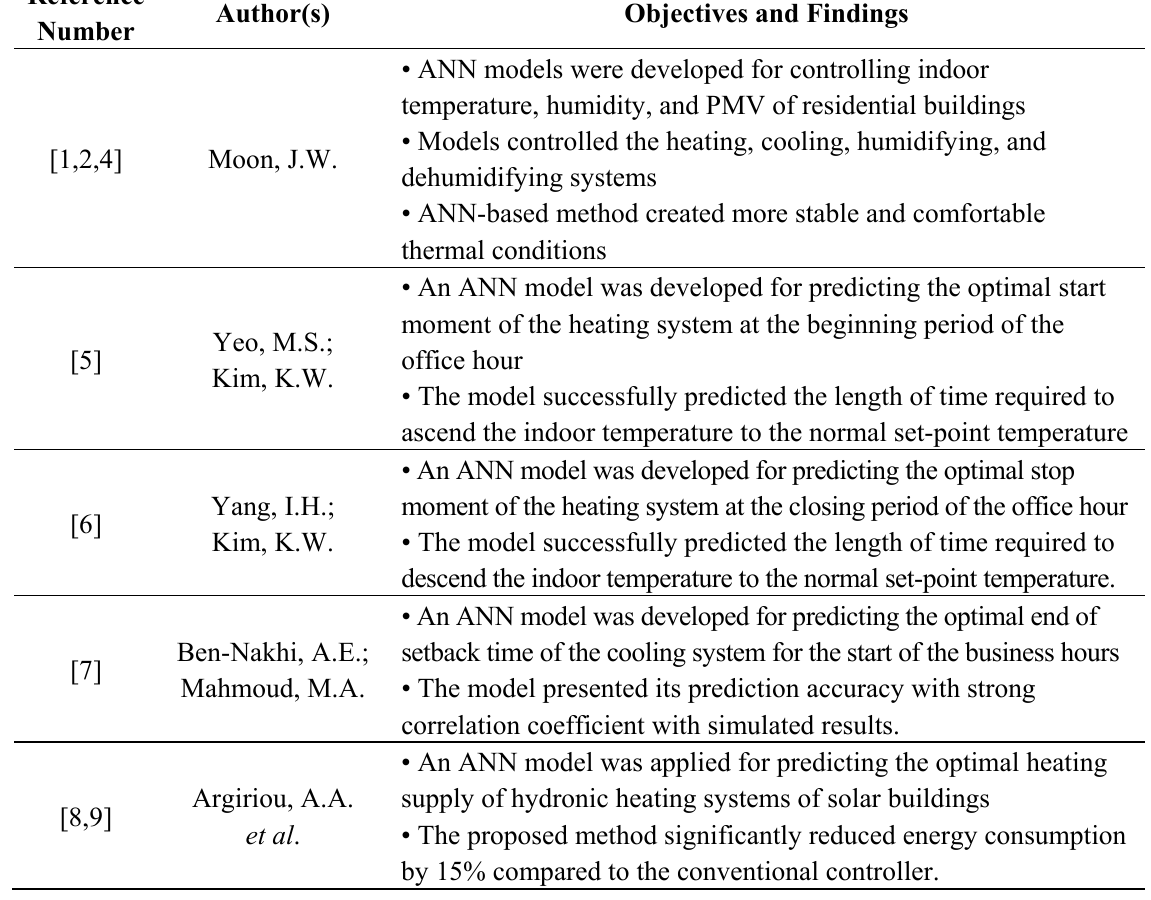
Table 1. Relevant studies using the ANN